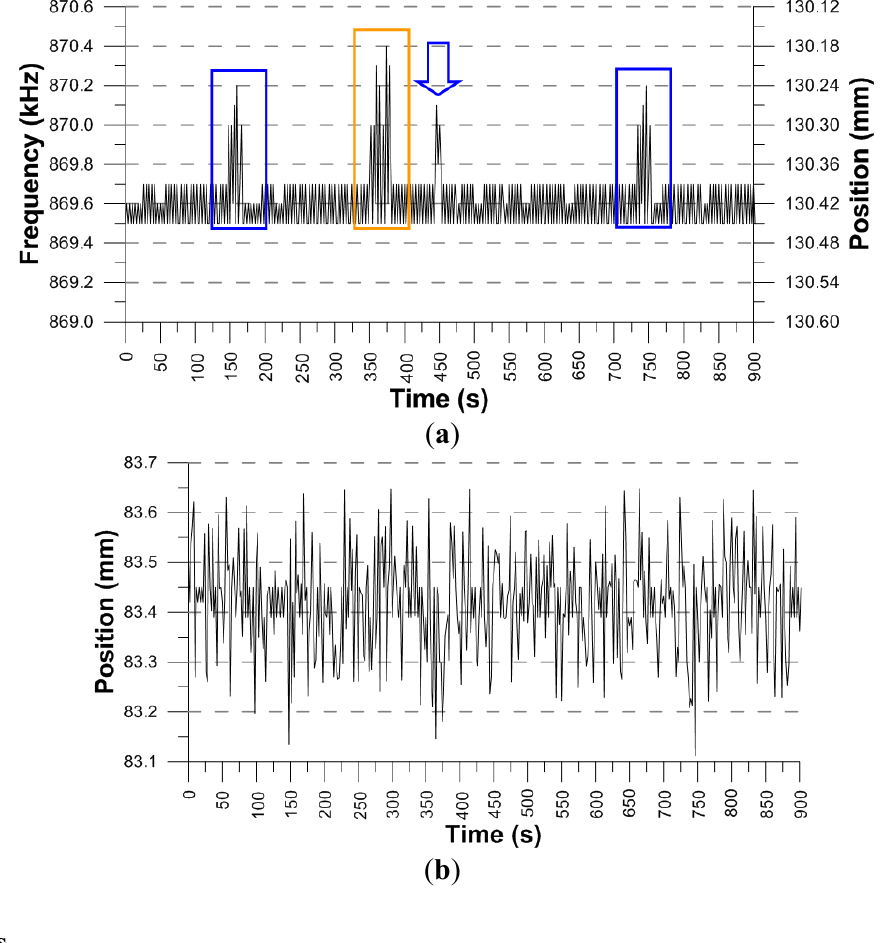
Figure 7. ( a ) Sensor response with a 280 mm length coil; ( b ) LVDT response under